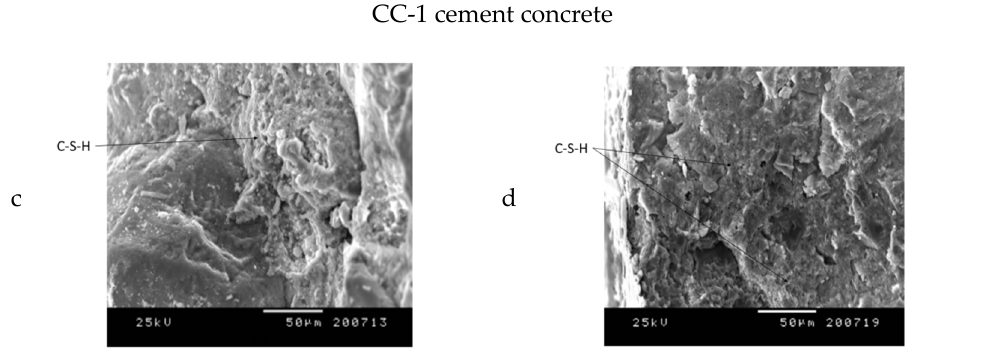
Figure 22. Concrete surface subjected to thermal cycles according to scheme A for CC-1 and CC-2 concrete: ( a ) sample surface, ( b ) chemical microanalysis.